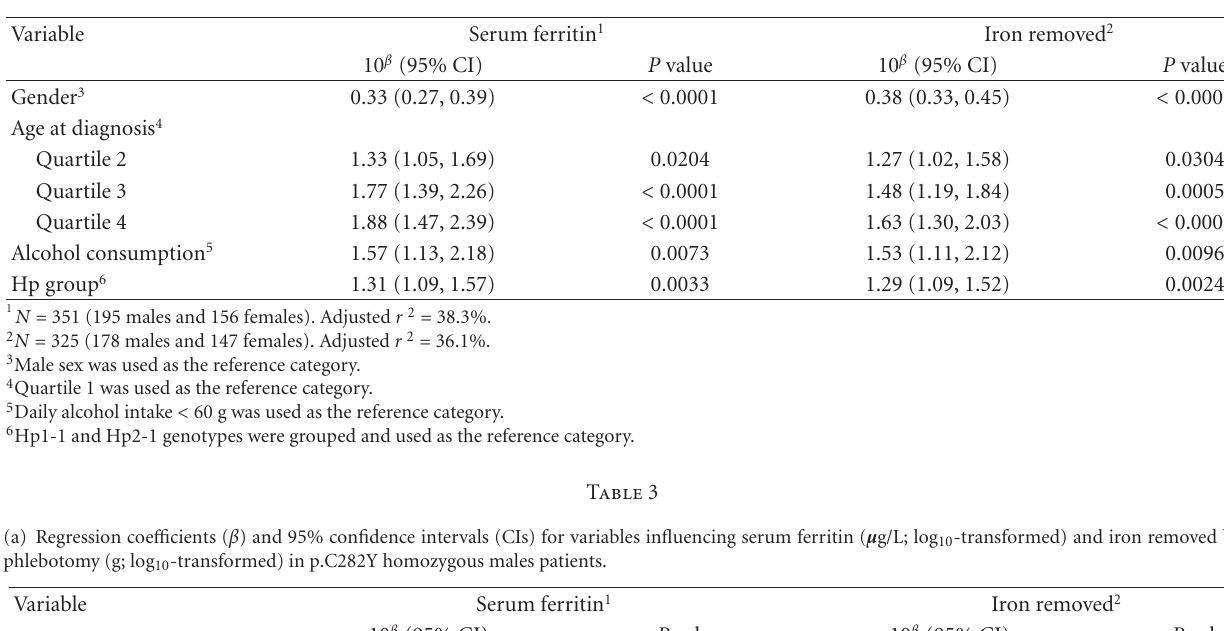
Table 2: Regression coe ffi cients ( β ) and 95% confidence intervals (CIs) for variables influencing serum ferritin ( µ g/L; log 10 transformed) and iron removed by phlebotomy (g; log 10 transformed) in p.C282Y homozygous